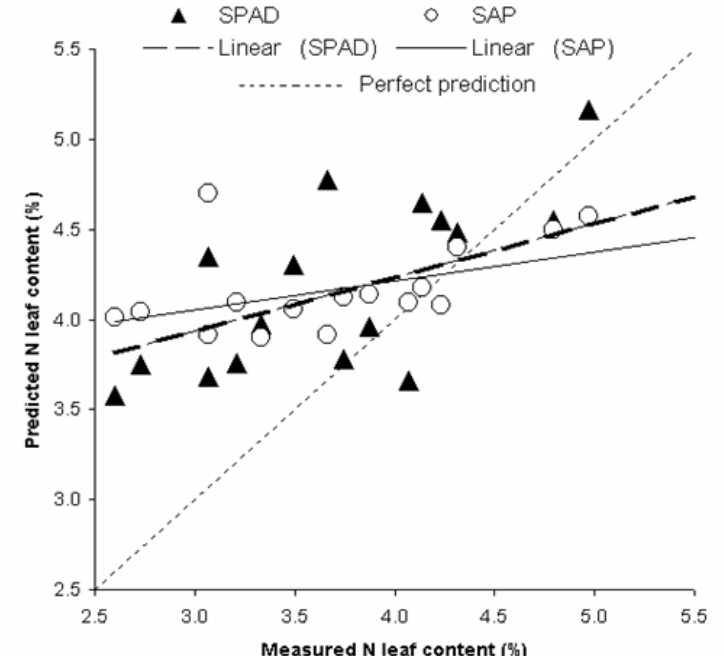
Figure 3. The correlation between measured and predicted values of N of SPAD (chlorophyll meter readings) and SAP (measurements of N-NO analysis in the test represented by the 15% of the whole sample dataset extracted by the SPXY (sample set partitioning based on joint X- and Y-blocks)